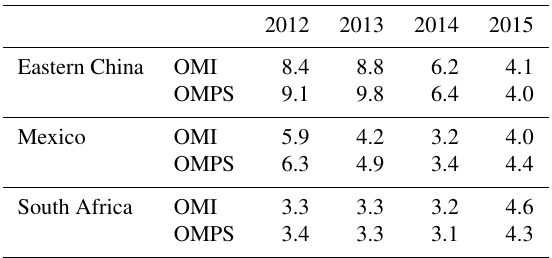
Table 5. Averaged SO 2 mass (unit: kt) over eastern China, Mexico, and South Africa in 2012, 2013, 2014, and 2015 for both OMI and OMPS.